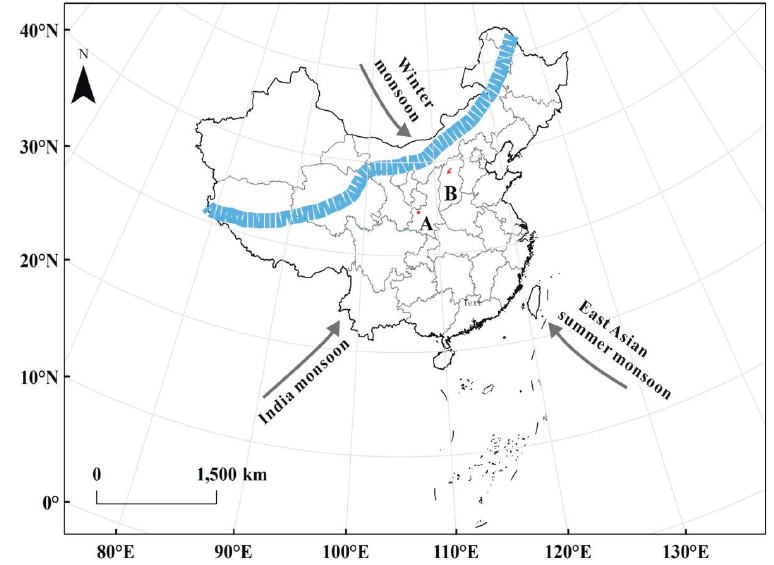
Figure 1. Precipitation sample collection site. (The blue dashed line denotes the northern limit of the Asian summer monsoon [29] (A,B) represent Fengxiang and Ningwu, respectively). The data of the map was downloaded from the National Geomatics Center of China (http: ngcc.sbsm.gov.cn/).